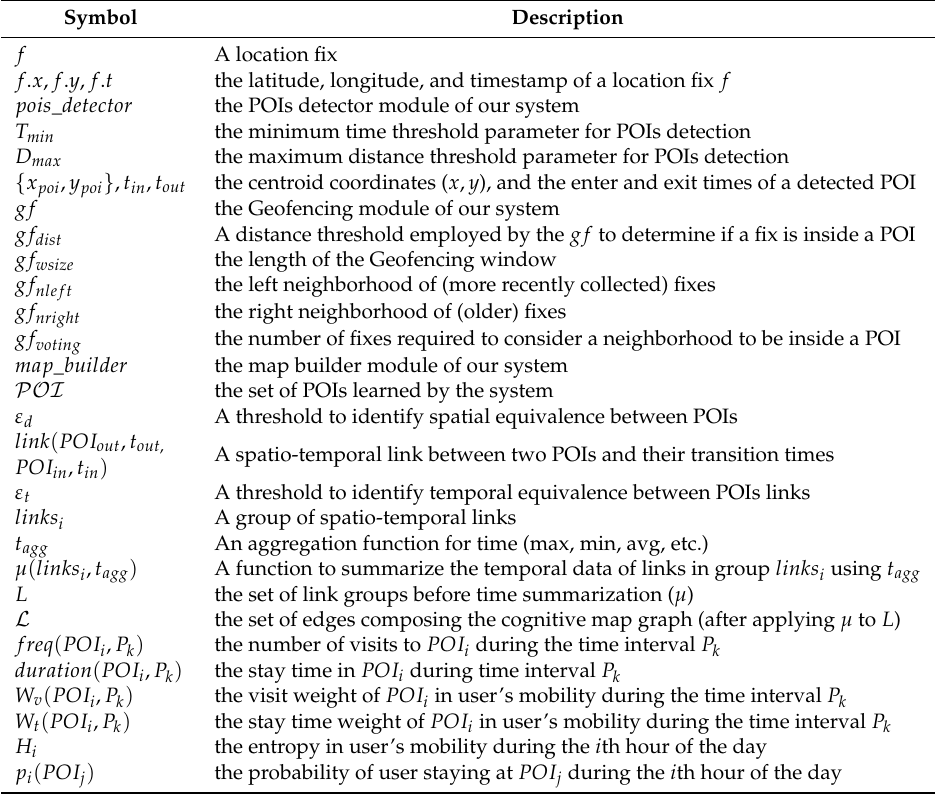
Table 1. Table of symbols and